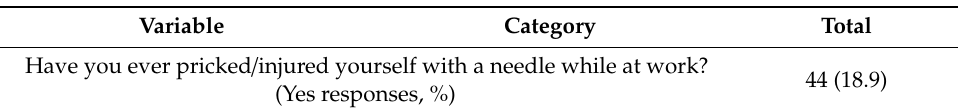
Table 2. Needlestick